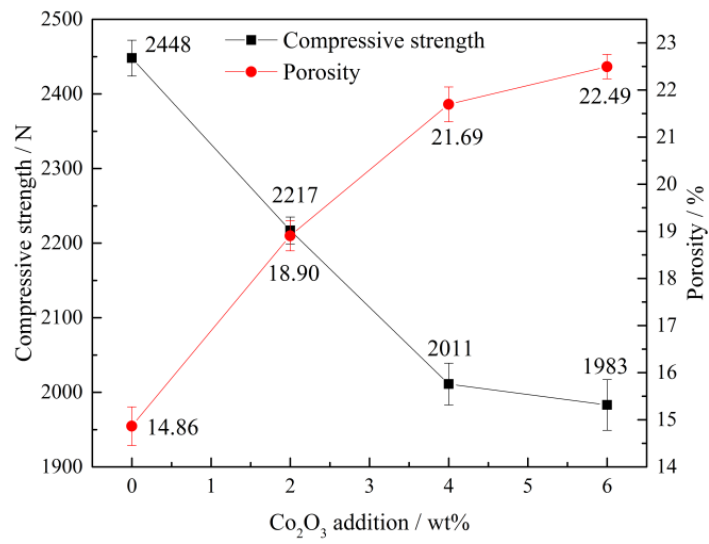
Figure 5. Effect of Co 2 O 3 additions on the compressive strength and porosity of CVTP.